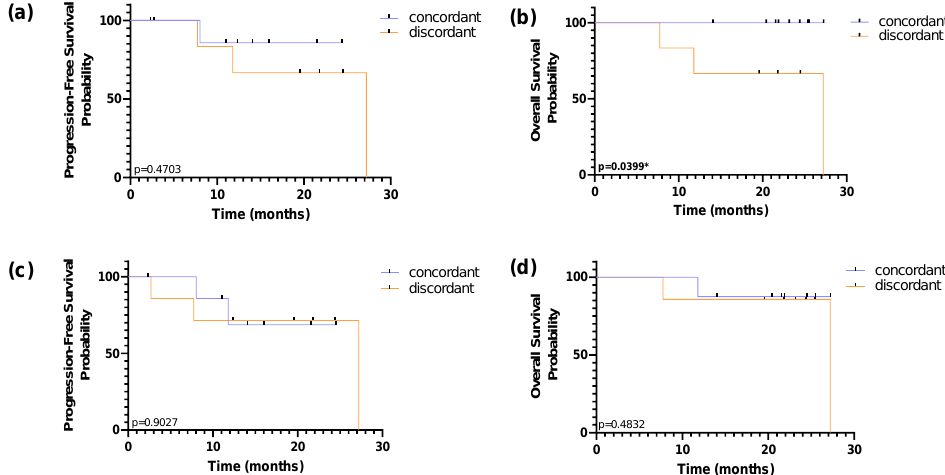
Figure 9. Kaplan–Meier curves of progression-free survival (PFS) and overall survival (OS) according to concordant or discordant HER2 status of CTC in relation to primary tissue assessment, using RUBYchip™ ( a , b ) and CellSearch ® ( c , d ) to isolate CTCs in MBC patients. PFS and OS were calculated from the time of the baseline blood collection. Differences in survival curves were determined using the log-rank test.